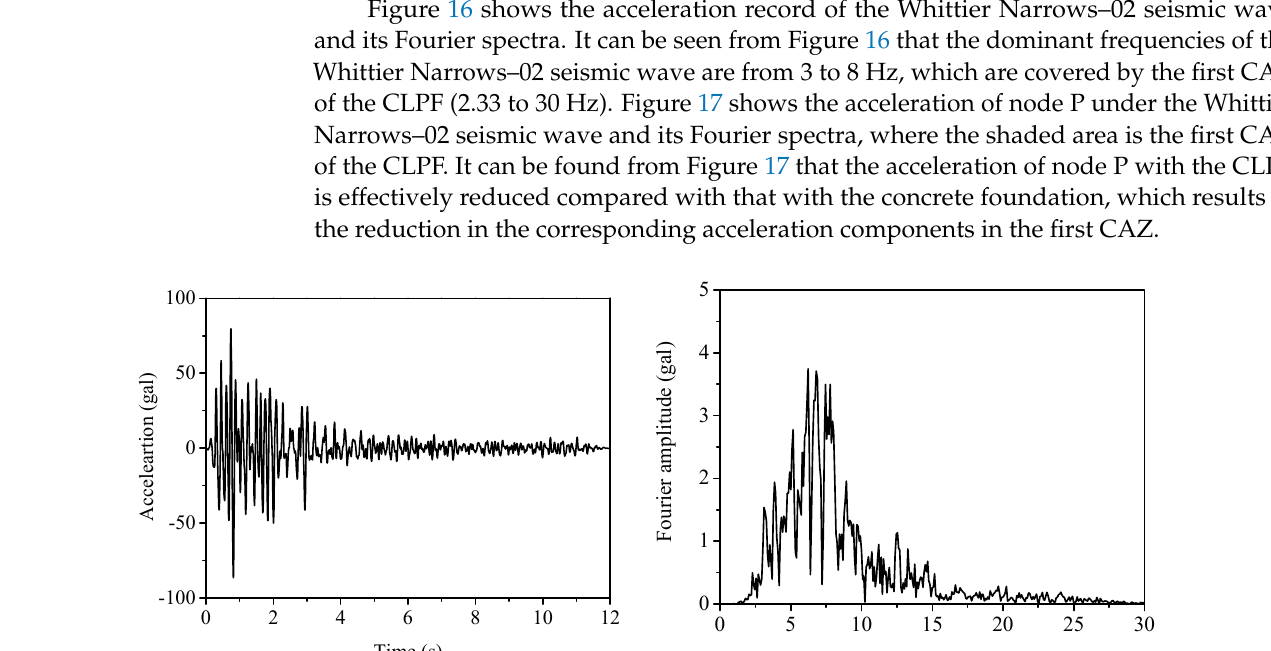
Table 2. Earthquake acceleration records.